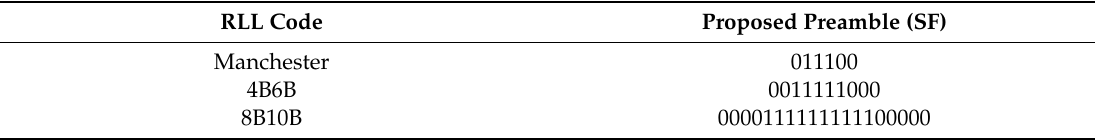
Table 1. Coding scheme and proposed preamble.